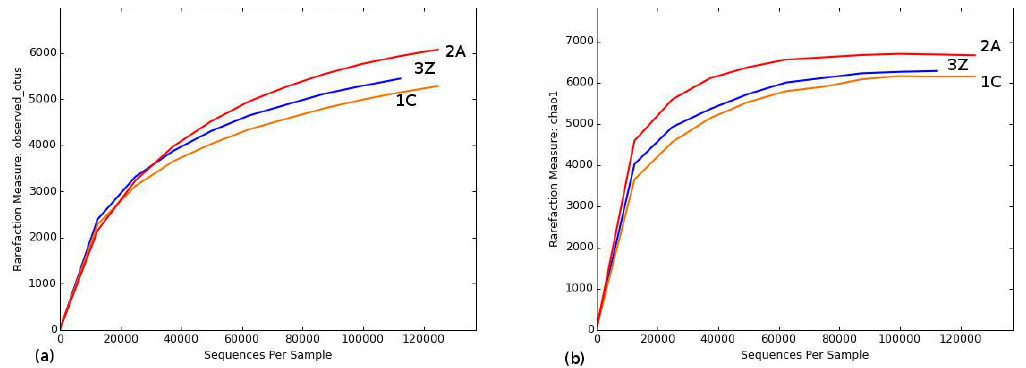
Figure 2. Rarefaction curves of alpha diversity indices. ( a ) Observed species curves and ( b ) Chao 1 curves, obtained for the samples. Alpha diversity was computed using observed species and Chao 1 metrics, respectively, with rarefied OTU table size of 100. 1C — control (untreated soil); 2A — Ag nanoparticle-treated soil; and 3Z — ZnO nanoparticle-treated soil.